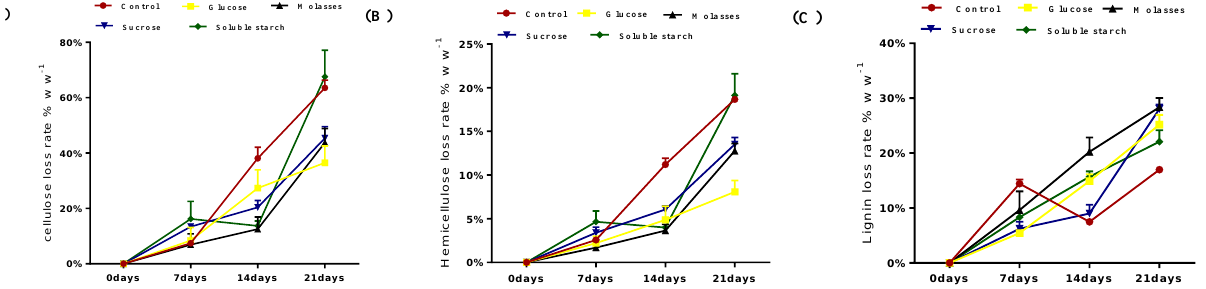
Figure 1. Loss rate of cellulose, hemicellulose, and lignin from corn stover during 21 days of solid–state fermentation with Phanerochaete chrysosporium . ( A ) Cellulose loss rate. ( B ) Hemicellulose loss rate. ( C ) Lignin loss rate.